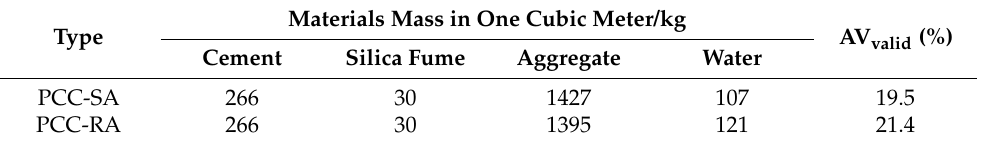
Table 6. Compositions of PCC-SA and PCC-RA.